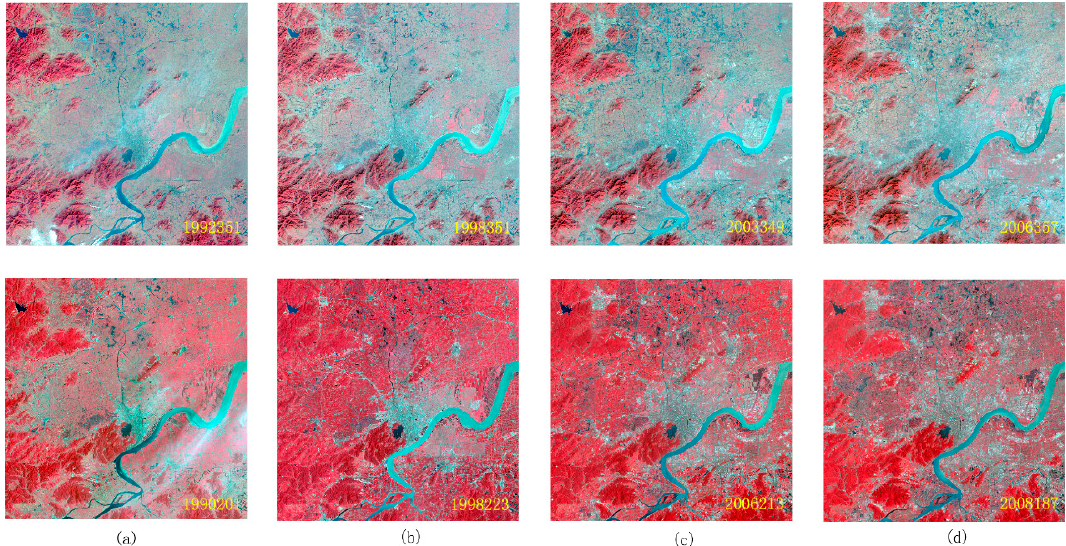
Figure 2. Time-series of remote sensing images from Landsat 5 over Hangzhou City. ( a )–( d ) represents four image acquired on 1990, 1998, 2003, and 2008, respectively, the images from the upper row were obtained on approximately the 350th days of different years, and those of the lower row were obtained on approximately the 205th days of different years.